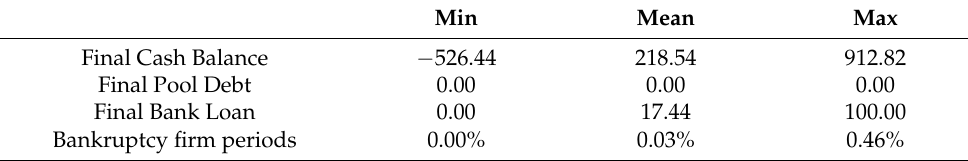
Table 15. Results for diverse operational risk and interest rates without cooperation.